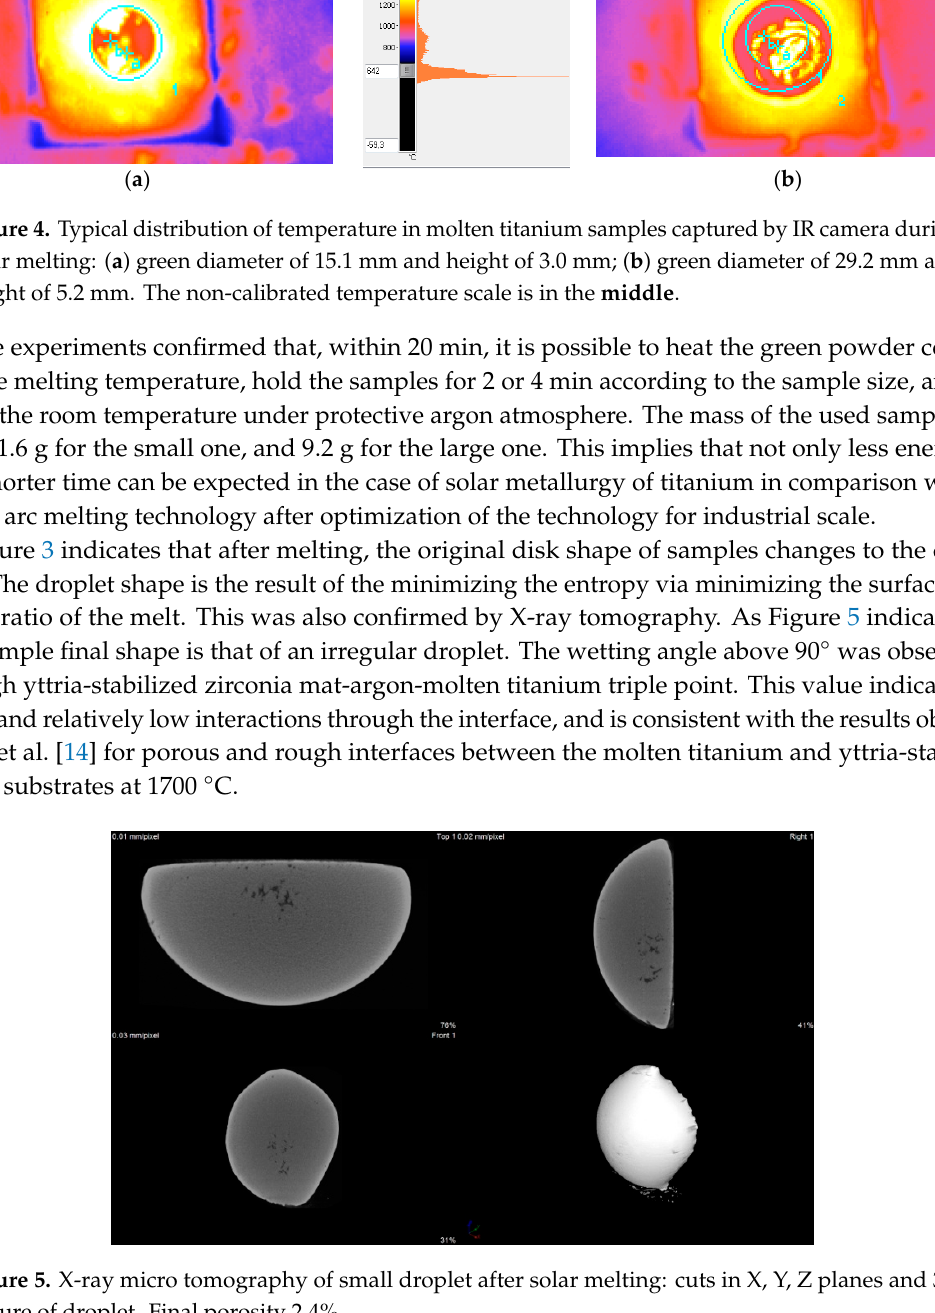
Figure 5. X-ray micro tomography of small droplet after solar melting: cuts in X, Y, Z planes and 3D picture of droplet. Final porosity 2.4%.